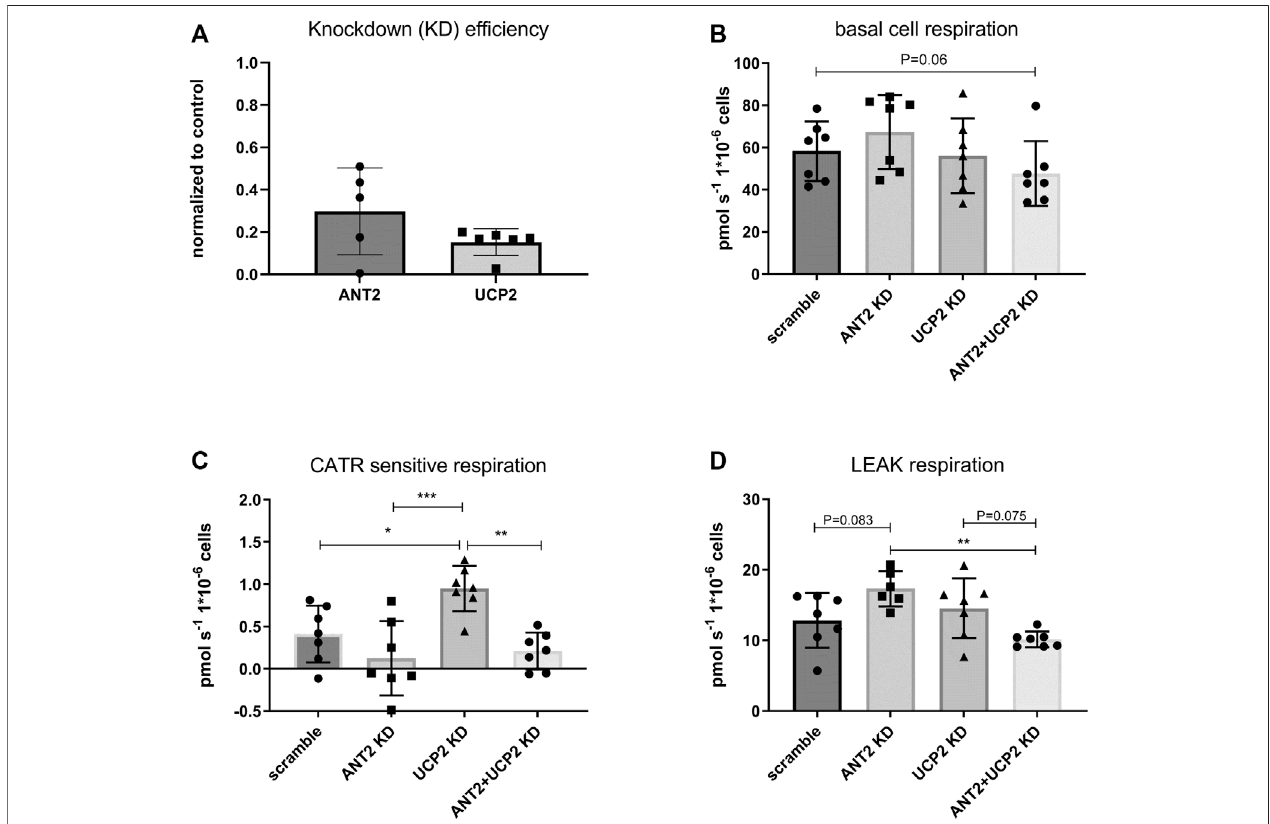
FIGURE 4 | ANT2 and UCP2 were knocked down (KD) in HEK293A cells using siRNA. The ef fi ciency of KD by siRNA was evaluated by rtqPCR (A) . Cells were harvested and diluted in respiration medium. Basal cell respiration wasmeasured byhigh-resolution respirometry. Respiration was normalized to cell number. Basal cell respirationwasmeasuredafterANT2andUCP2KD. (B) .CATR sensitiverespirationwasdetermined inpermeabilizedcellsandde fi nedasthechangeinrespirationafter the addition of CATR during leak respiration. (C) . Leak respiration was measured in permeabilized cells (digitonin) in presence of complex II substrates (succinate) rotenone and oligomycin (D)